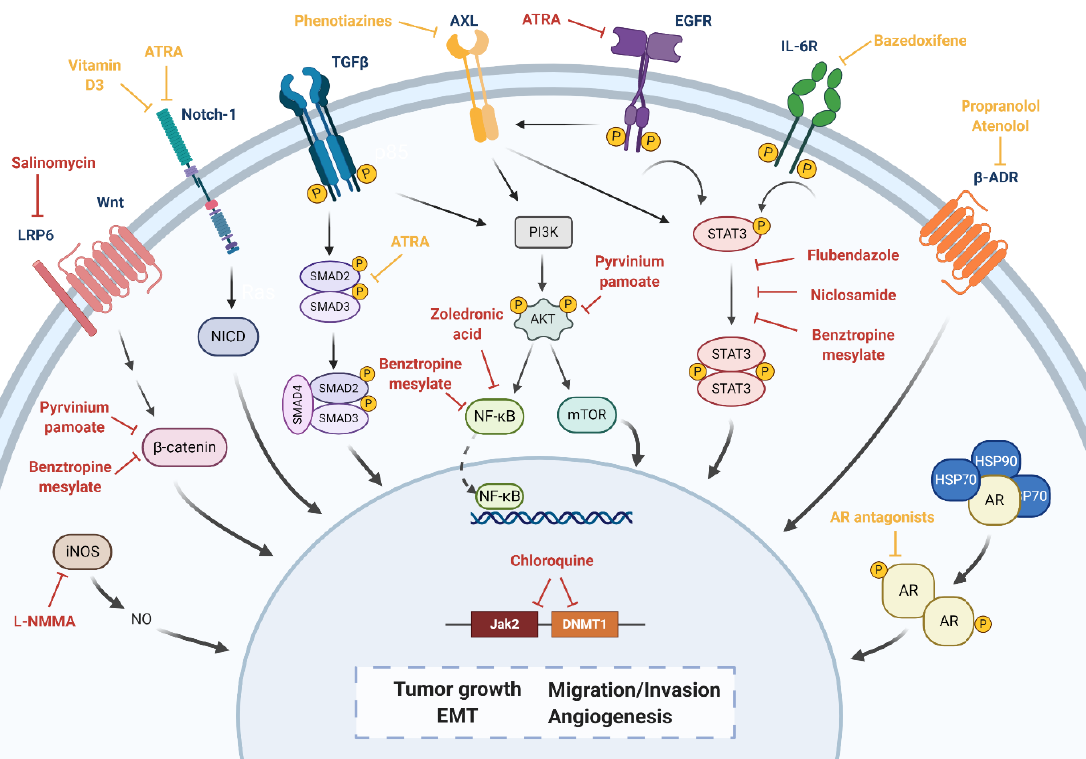
Figure 4. Overview of the different pathways investigated by drug repurposing to target breast cancer stem cells (BCSCs) and their potential inhibitors / modulators. Repurposed inhibitors under investigation are shown in red. Hypothesized inhibitors are shown in yellow. Created with BioRender.com.